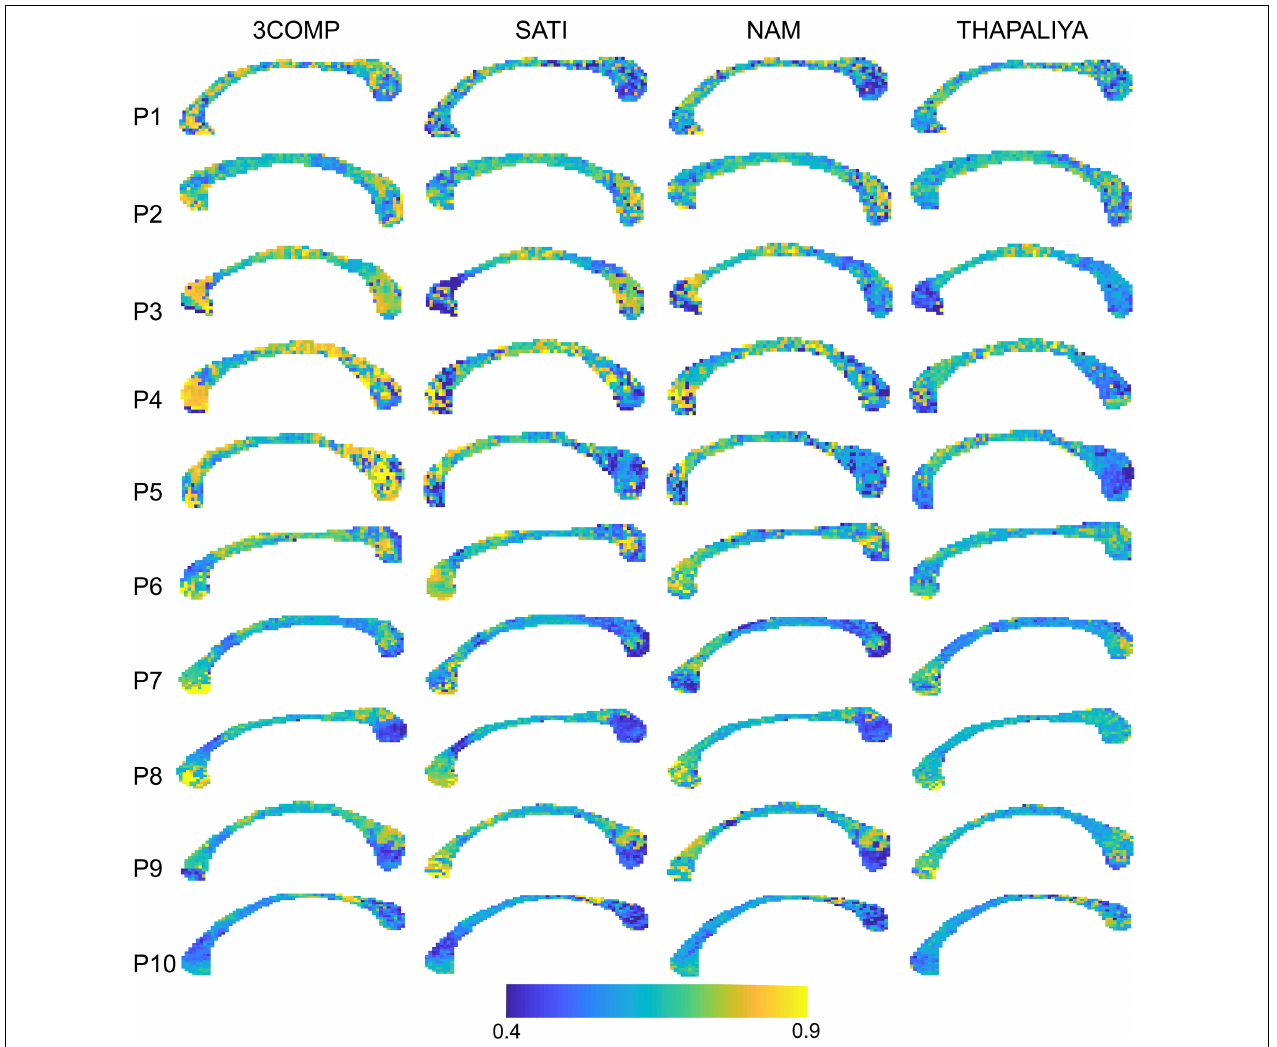
FIGURE 7 | Maps of g-ratio over the corpus callosum estimated using three-signal compartment models (3COMP, Sati, Nam, and Thapaliya) in the 10 participants